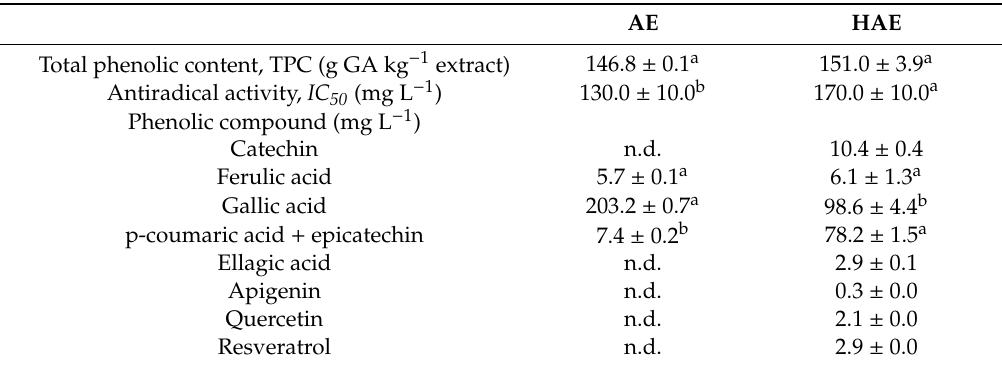
Table 1. Characterization of R. microphylla (Rm) fruit extracts. AE HAE Total phenolic content, TPC (g GA kg − 1